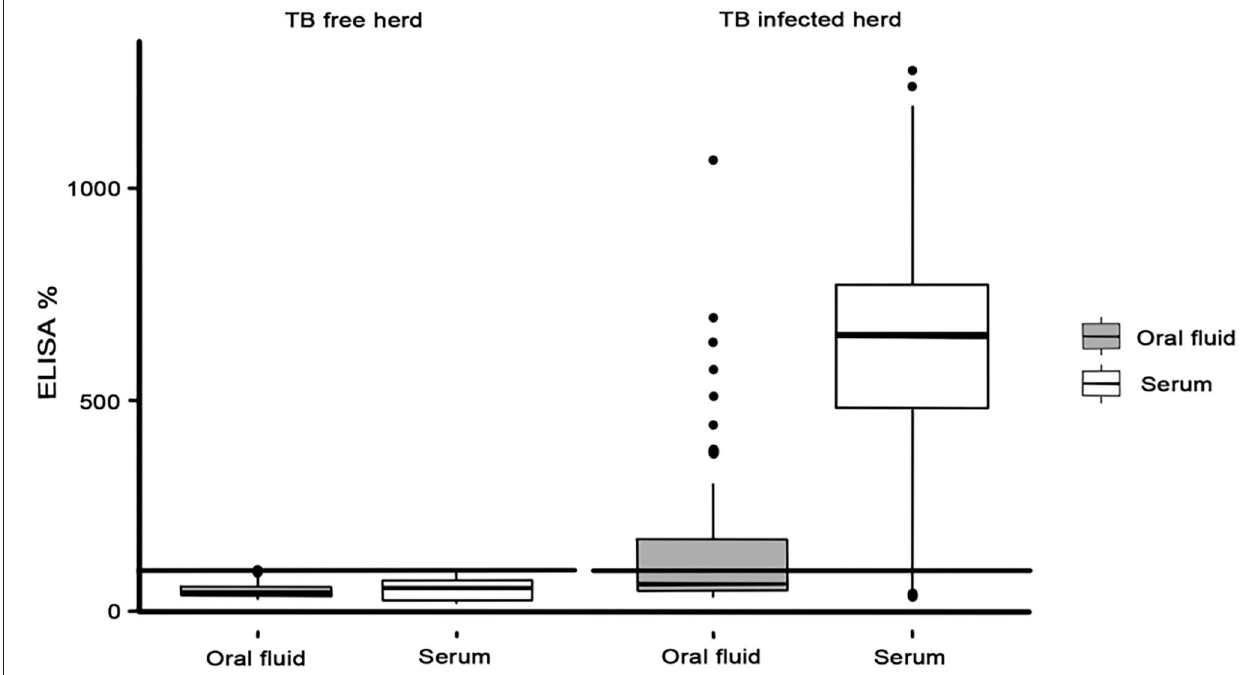
a SIT, Single intradermal tuberculin test: protocol and interpretation was performed according to Council Directive 64/432/EEC and Royal Decree RD2611/1996. b CIT, Comparative intradermal tuberculin test: protocol and interpretation was performed according to Council Directive 64/432/EEC and Royal Decree RD2611/1996. c IGRA, interferon-gamma release assay: an animal was considered positive to IGRA if the optical density (OD) of a sample stimulated with bovine PPD minus the OD of the aliquot stimulated with PBS (nil) was > 0.05 and greater than the OD of the sample stimulated with avian